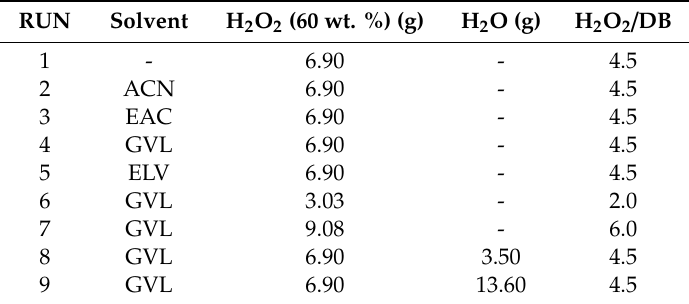
Table 2. Epoxidation runs